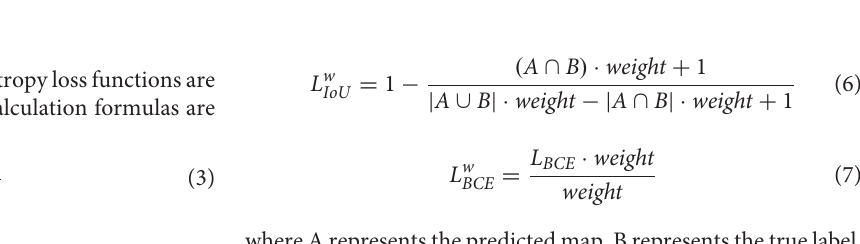
FIGURE 6 | Frame diagram of the reverse attention module: Including Sigmoid activation function, concatenation operation, multiplication operation and reverse operation. f i (i = 3,4,5) represents the feature information obtained by the picture through the i -th convolutional layer. S i + 1 ( i = 1 , 2 ) represents the information obtained by the combination of the reverse attention module information and the higher-level information. A i represents the output after S i + 1